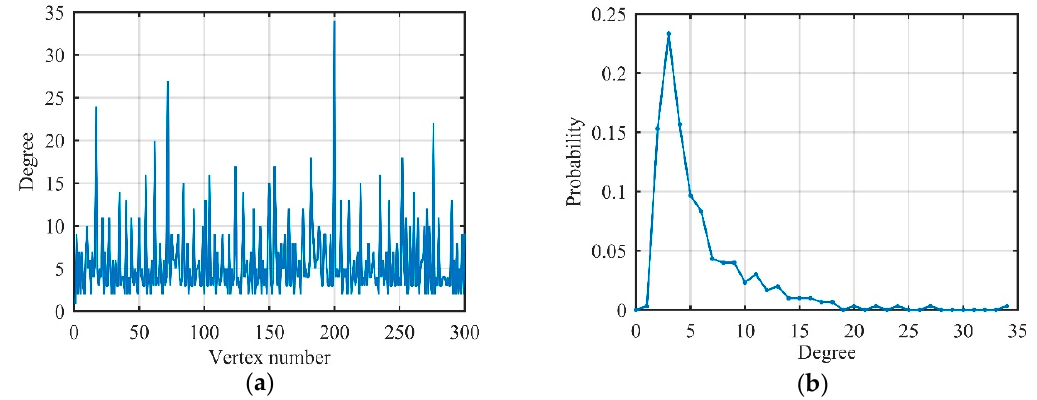
Figure 8. Related degree features of Gaussian noise on visibility graphs. ( a ) Degree of each vertex; ( b ) degree distribution.